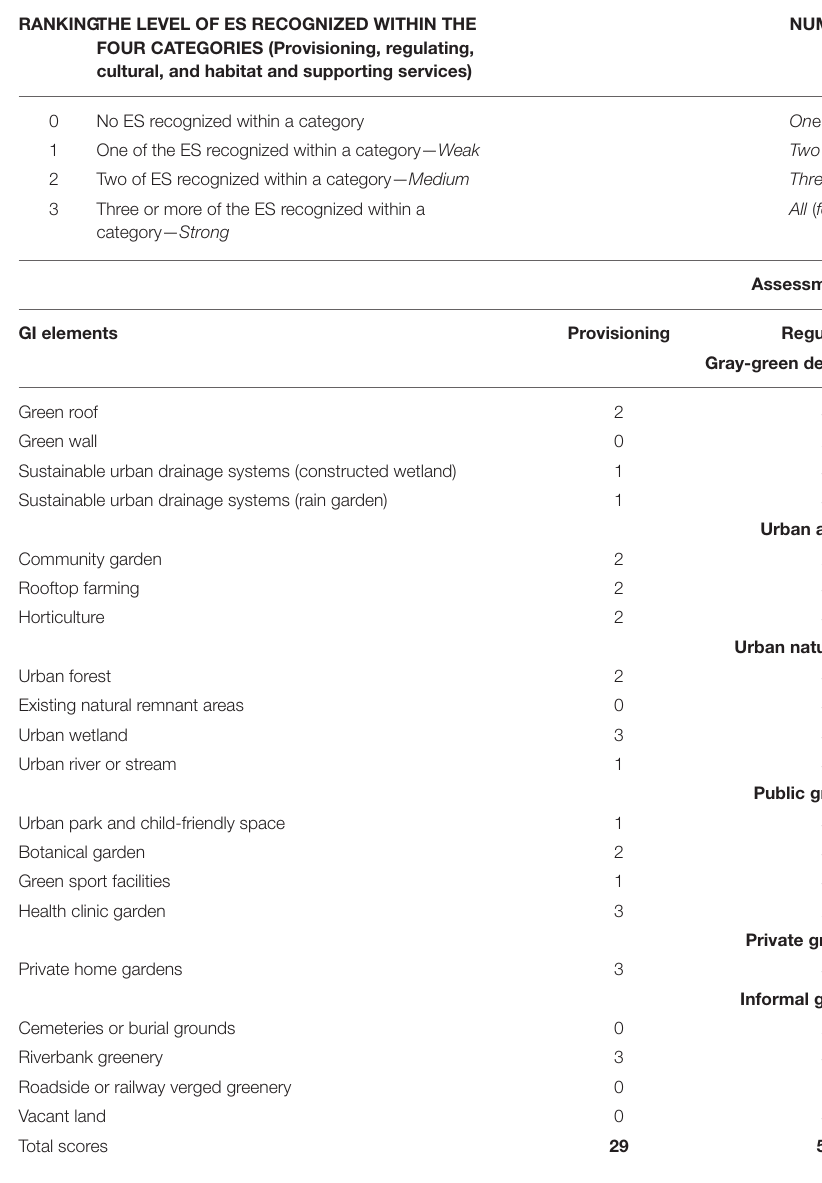
TABLE 3 | Self-assessment criteria and results of the different GI elements in the case studies.